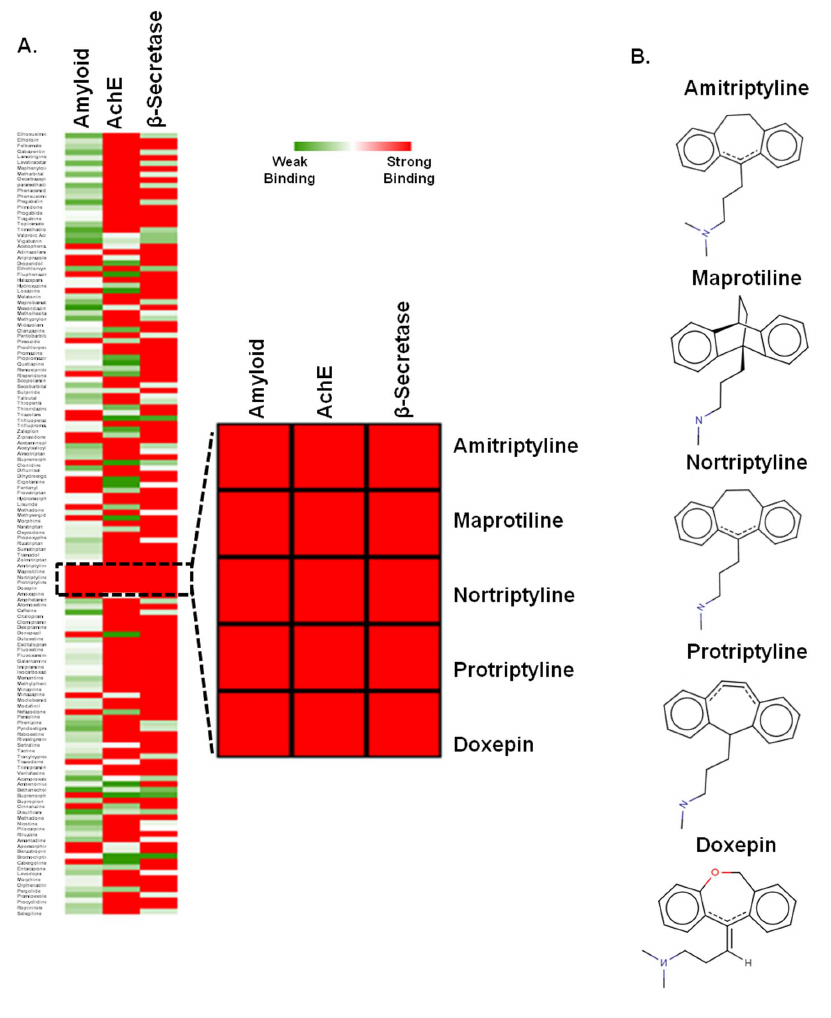
Figure 1. Virtual screening by docking. A . Heat map analysis of binding constants of 140 FDA approved nervous system drugs screened against A b , AChE and b -secretase by Autodock tool 4.2. In the gradient ruler, red colour indicated strong binding ( D G ,2 6 kcal/mol), while green colour indicate weak binding ( D G .2 3 kcal/mol) and the five drugs showing higher affinity to all the above mentioned targets were zoomed. B . Chemical structures of the five drugs. All are tricyclic anti-depressant drugs.